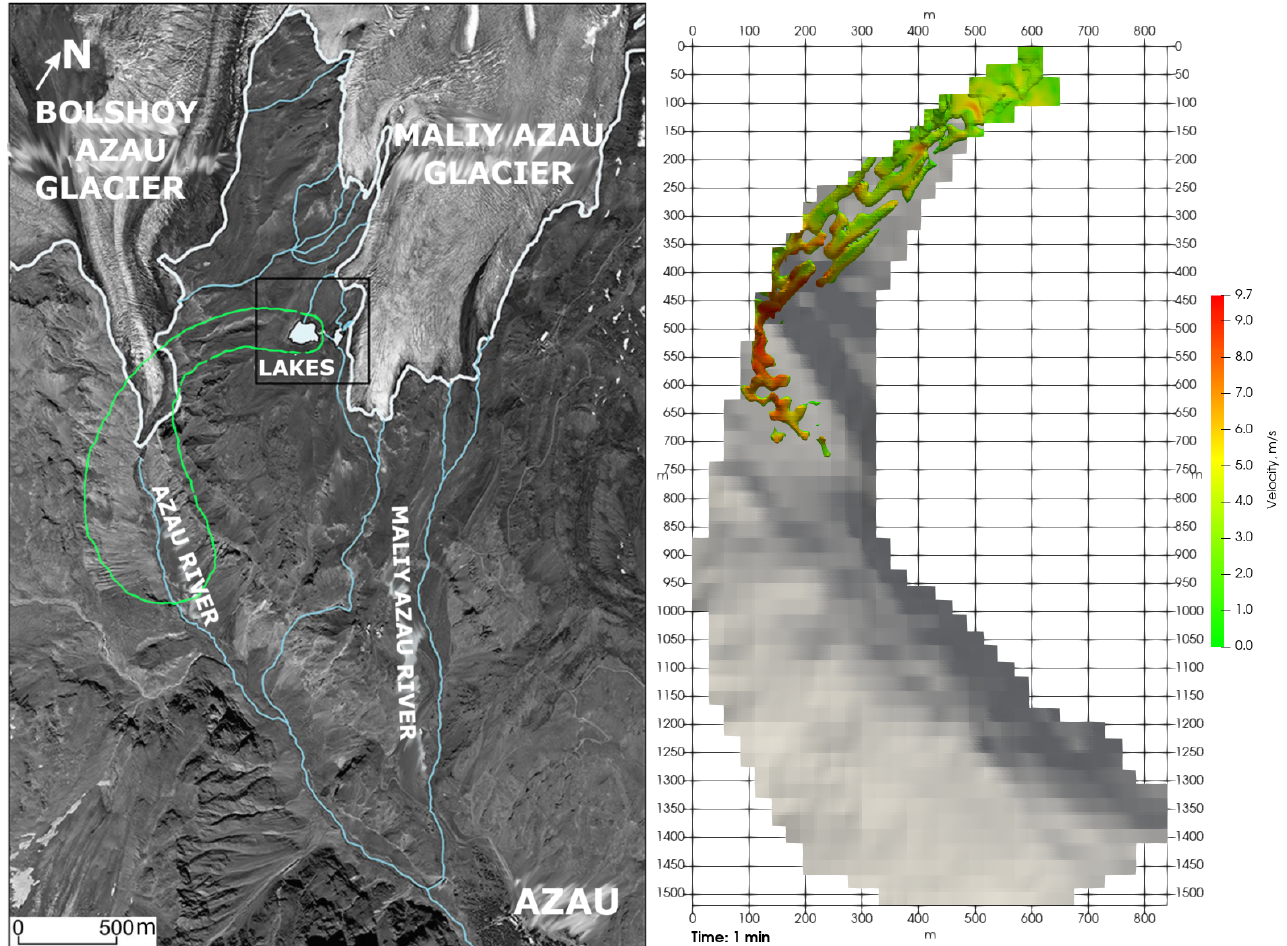
Figure 10. Maliy Azau glacial lake outburst flood map [50] ( left ) ; 3D simulation of outburst flood 1 minute after start ( right